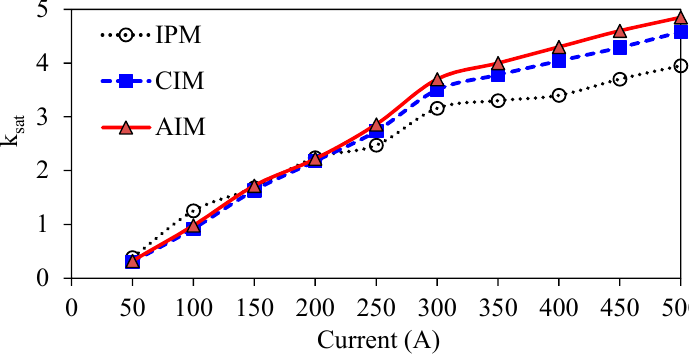
Figure 12. Variation of saturation factor with respect to electric loading.